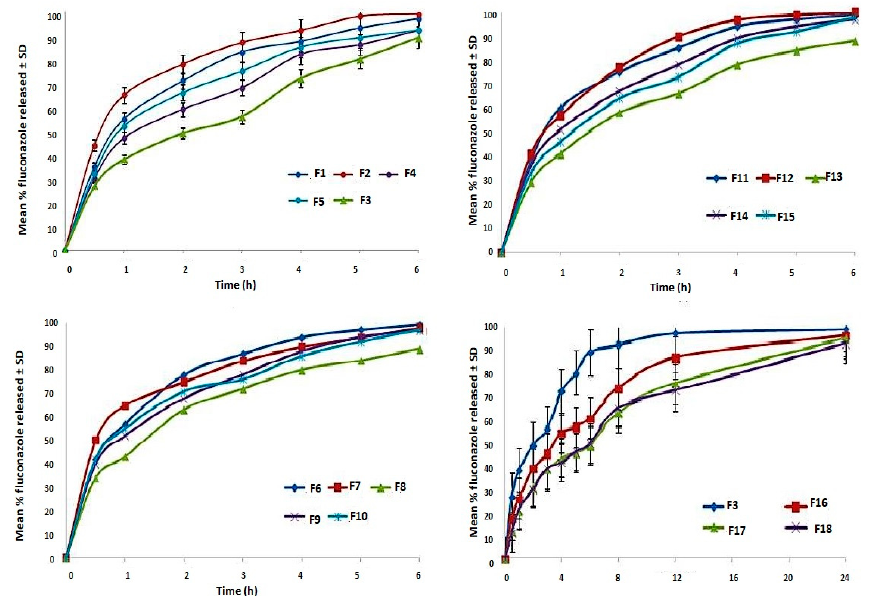
Figure 4. Fluconazole release from chitosan/anion polyelectrolyte based lyophilized vaginal inserts in phosphate buffer PH 4.5 (Data is represented as mean ± SD, n = 3).